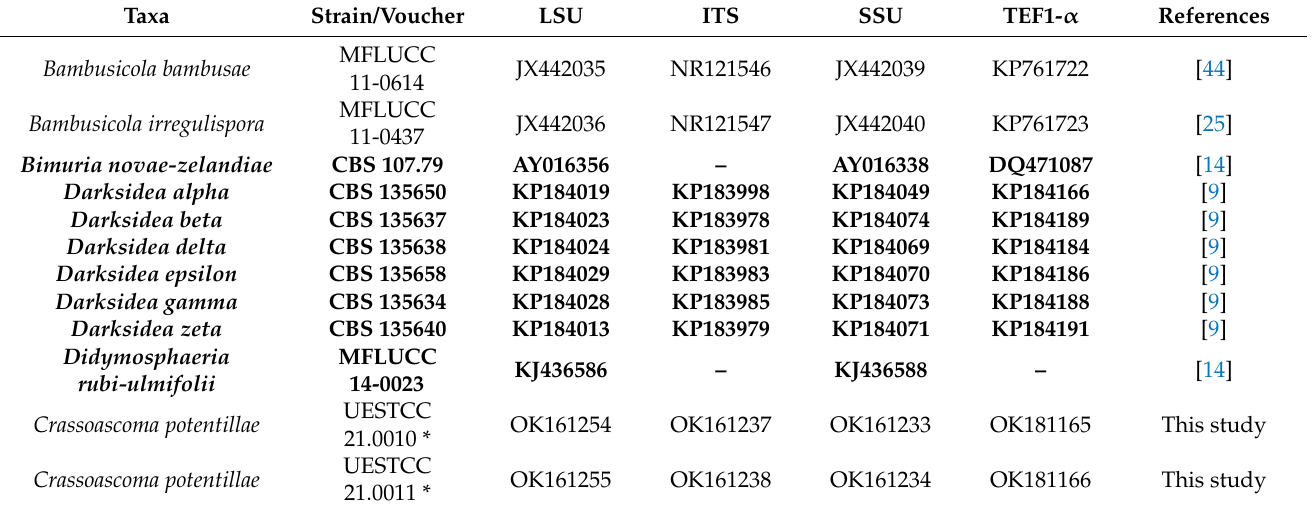
Table 1. Taxa used in this study and their GenBank accession numbers. Newly generated sequences are indicated with * and the ex-type strains are in